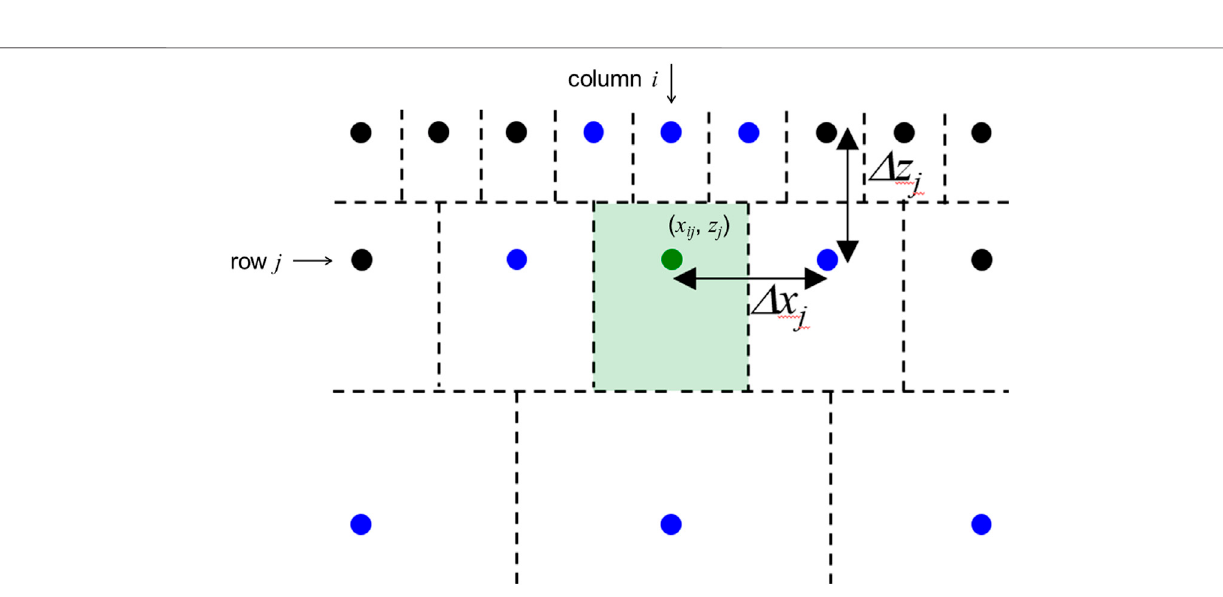
FIGURE 3 | Interpolating points for a typical control volume